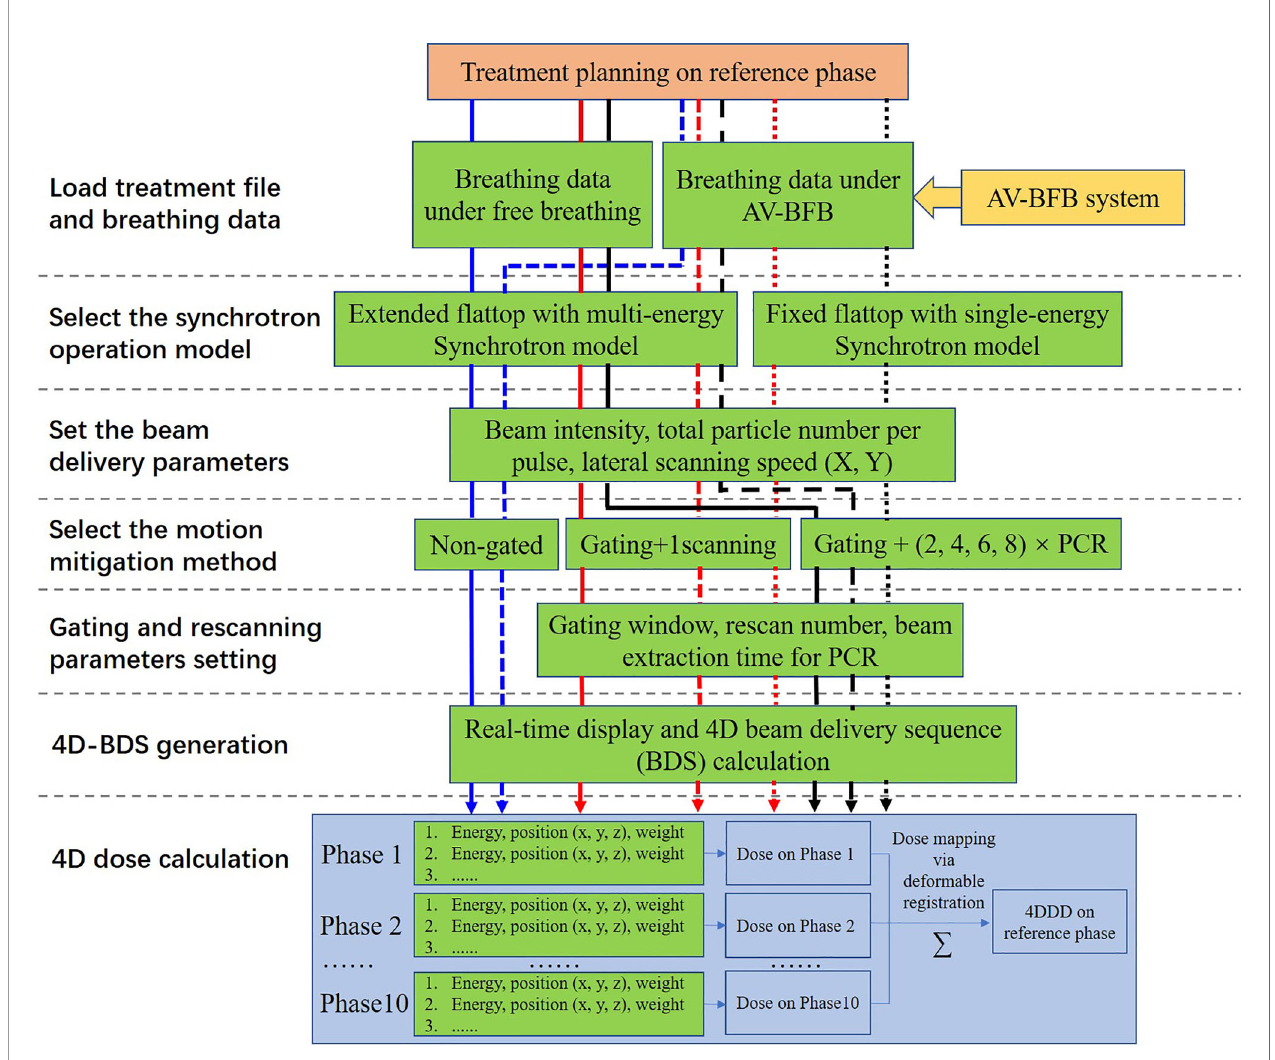
FIGURE 2 | Schematic representation of the simulation strategy and calculation process adopted in this